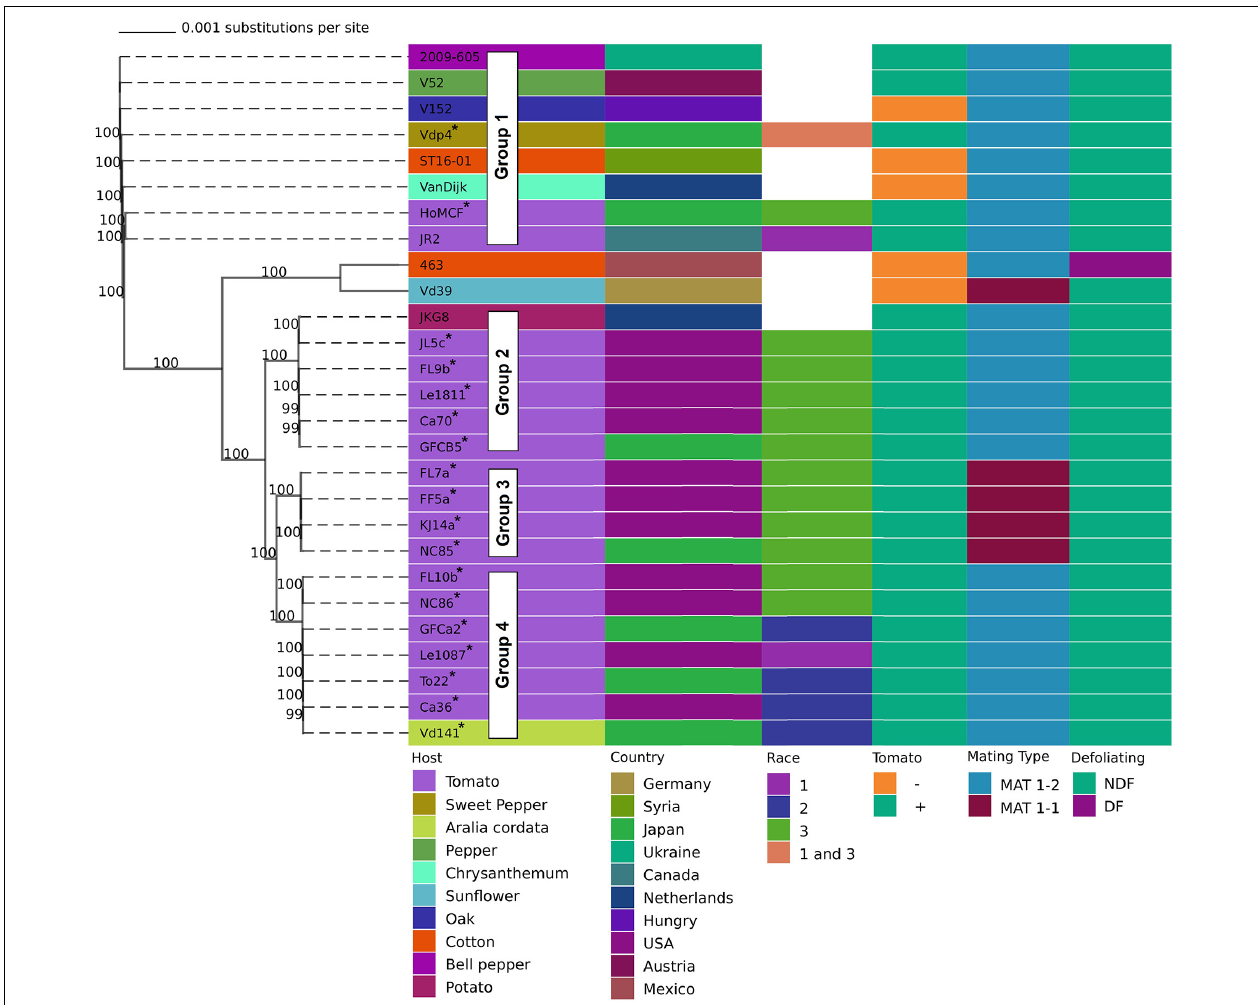
Figure 1 . Among the isolates in this study, strains classified as